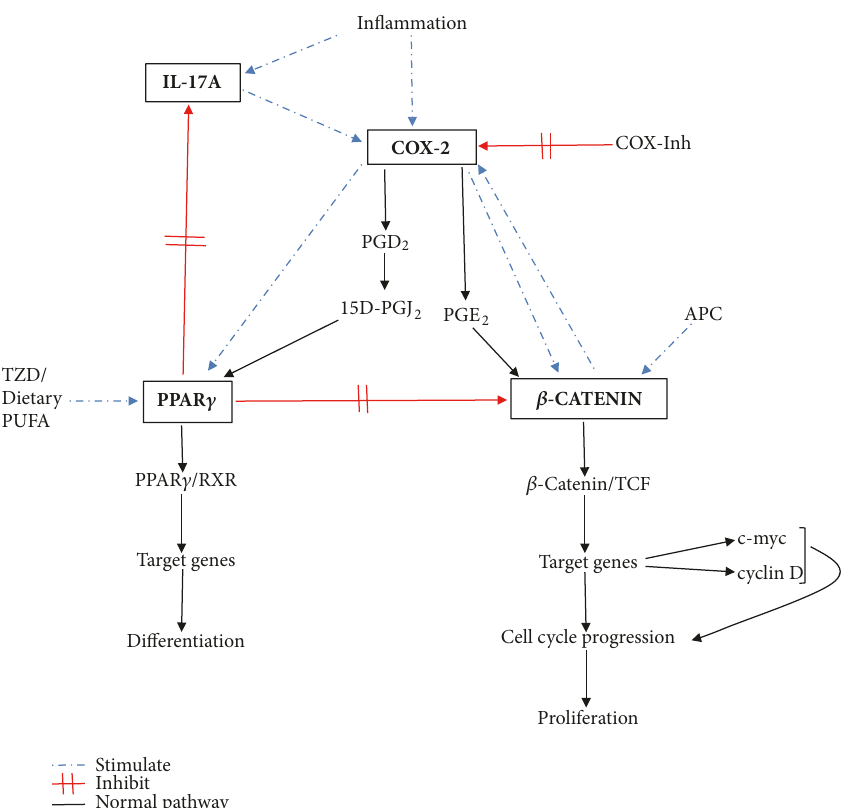
Figure 6: Interaction and regulation between COX-2, 𝛽 -catenin, PPAR 𝛾 , and IL-17 in colorectal carcinogenesis. TZD: thiazolidinediones, PUFA: poly-unsaturated fatty acids, TCF: T cell factor, RXR: retinoic acid receptor, and Inh: